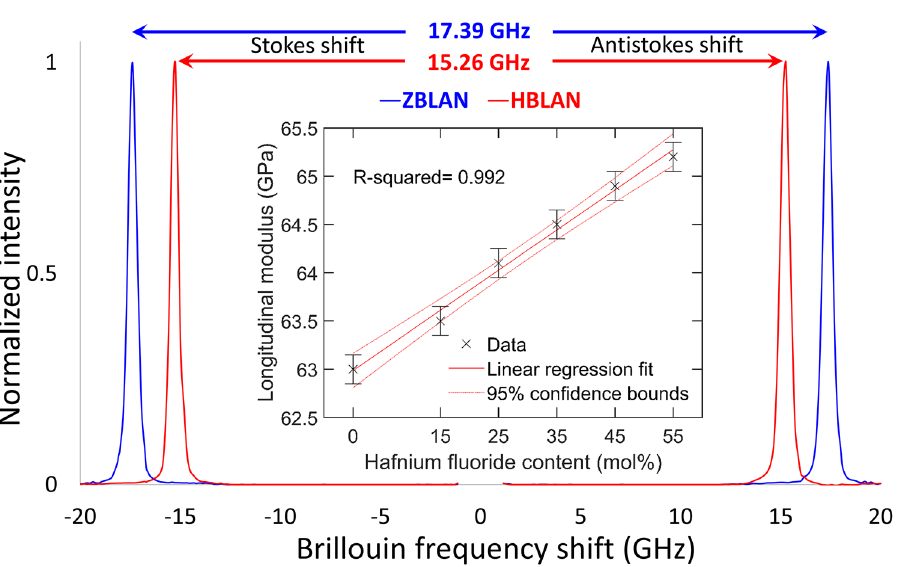
Figure 2. Brillouin frequency shift spectra for ZBLAN and HBLAN glasses. Inset: The longitudinal modulus for all custom glasses calculated based on Brillouin scattering